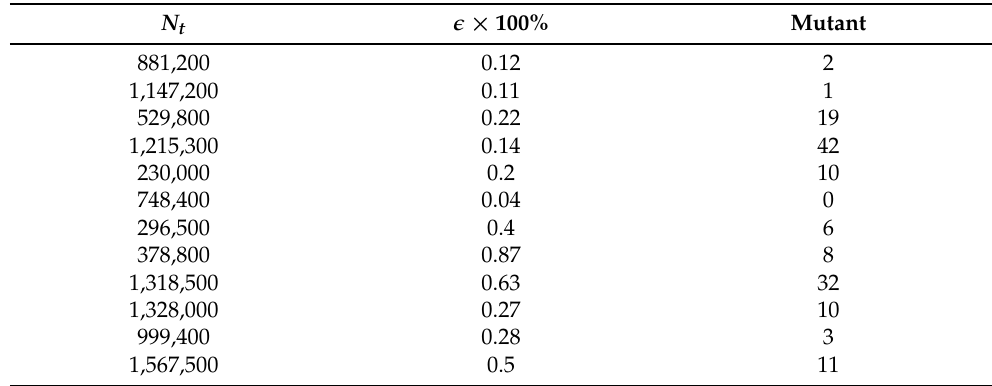
Table 4. Fictitious data set A ( w = 1.5).